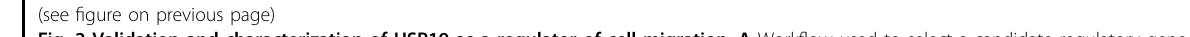
Fig. 2 Validation and characterization of USP19 as a regulator of cell migration. A Work fl ow used to select a candidate regulatory gene. MDAMB231 cells were stably transduced with control empty vector shRNA (control) or two different shRNAs (#1 & #2) targeting USP19. B Ef fi ciencies of shRNA-mediated knockdown were con fi rmed by RT-PCR (top, n = 5, one-way ANOVA, Dunnett ’ s multiple comparison test. shRNA#1 p = 0.0329 and shRNA#2 p = 0.0013) and Western Blotting (middle and bottom, n = 4, one-way ANOVA, Dunnett ’ s multiple comparison test. shRNA#1 p = 0.0227 and shRNA#2 p = 0.0006). ( C ) Crystal violet (CV) staining was used to determine cell growth over time. Cells were seeded onto wells and allowed to attach. At the indicated time points, cells were fi xed and then stained at the end of the experiment. The graph on the top shows the mean relative CV absorbance every 24 h. Doubling time was calculated for control and USP19 silenced cell lines on the bottom ( n ≥ 3, Kruskal – Wallis, Dunn ’ s multiple comparison test. shRNA#1 p > 0.9999 and shRNA#2 p > 0.9999). The migratory potential was evaluated by two different experiments. D Transwell assay: After 24 h of incubation, USP19-depleted cells were stained for microscopic examination and the number of migratory cells was compared to control cells. The graph shows the number of migratory cells per transwell membrane ( n = 4, one-way ANOVA, Dunnett ’ s multiple comparison test. shRNA#1 p = 0.0187 and shRNA#2 p = 0.0001). E Wound-healing assays: scratching with a pipette tip made a gap on a monolayer of the different cell cultures, and time-lapse imaging monitored the number of migrating cells across the border. After 8 h, cells exhibited different levels of migration. The graph on the left shows the gap covered area (mm 2 ) after 8 h ( n = 16, one-way ANOVA, Dunnett ’ s multiple comparison test. shRNA#1 p < 0.0001 and shRNA#2 p < 0.0001) and the images on the right show representative areas in a wound-healing experiment at the indicated time points. Scale bar = 100 μ